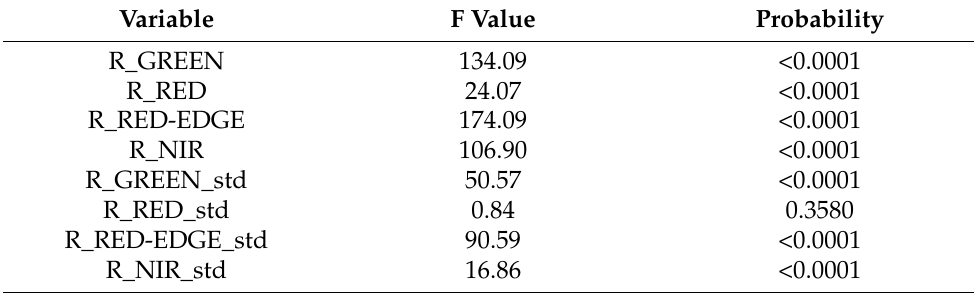
Table 3. Results of ANOVA on rank variables. R before the name of the variable means